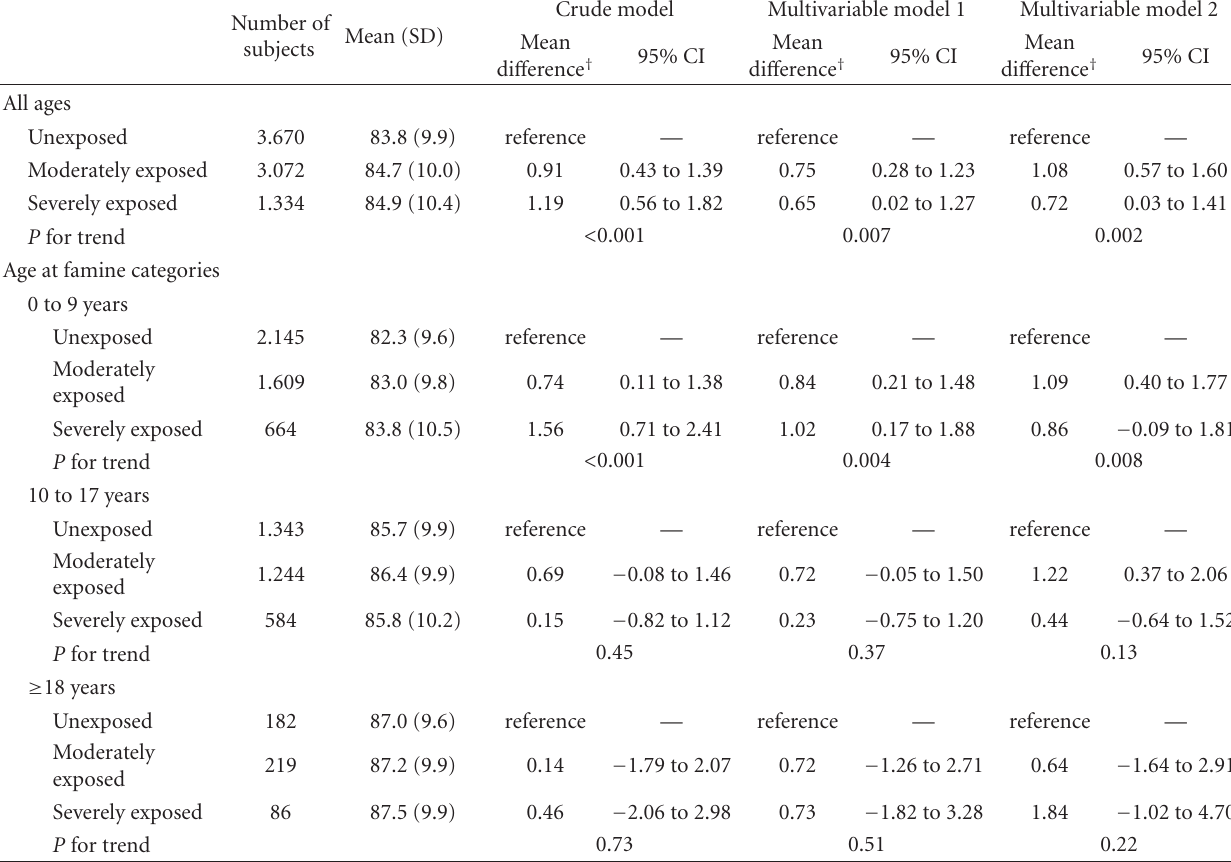
Table 3: Waist circumference: means, (un)adjusted di ff erences, and 95% confidence intervals (CIs) for women of all ages combined and within each of the three exposure age categories: 0–9 years, 10–17 years, and ≥ 18 years who reported to be moderately or severely exposed to famine compared to those who reported to be unexposed to